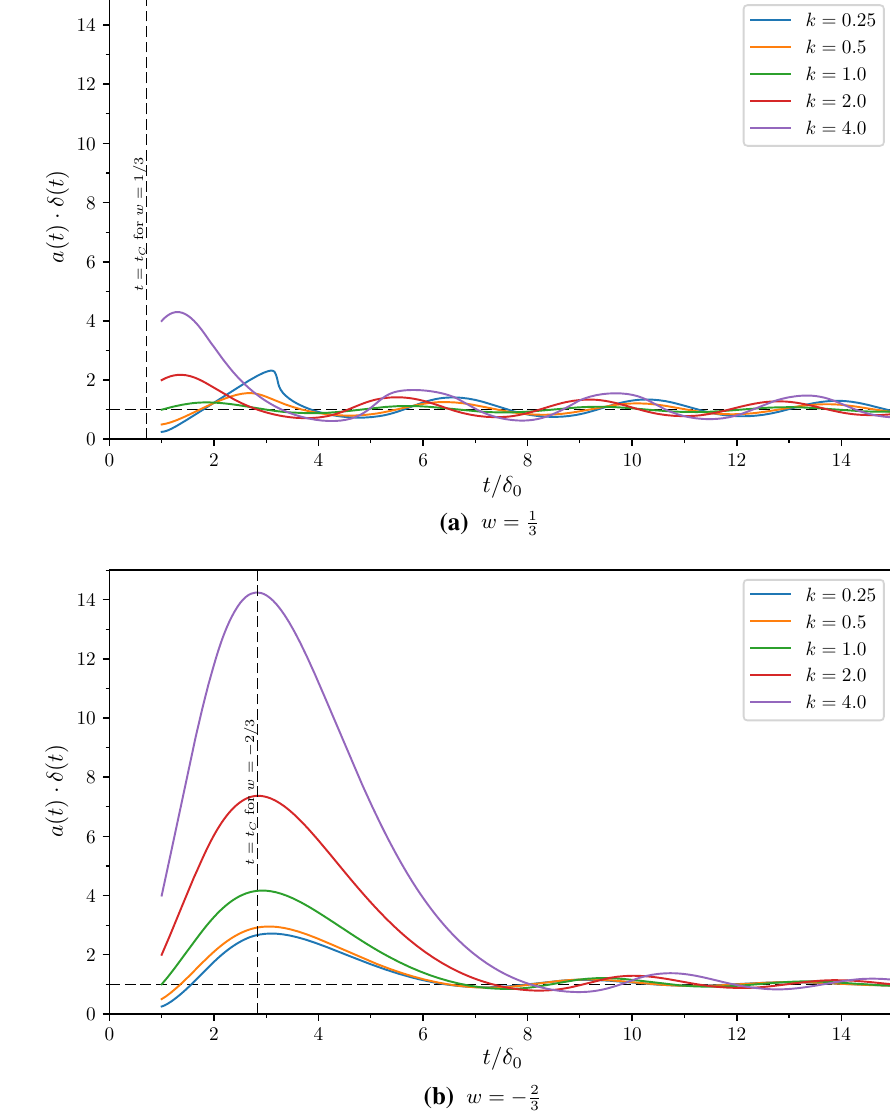
Fig. 9 Time dependence of the physical thickness of the wall, a ( t )δ( t ) , for different values of stretch parameter k . Dashed horizontal line corresponds to δ /δ = 1 . 0. 0 . For both plots t i 0 Vertical dashed lines correspond to the moment t C at which C ( t C ) =